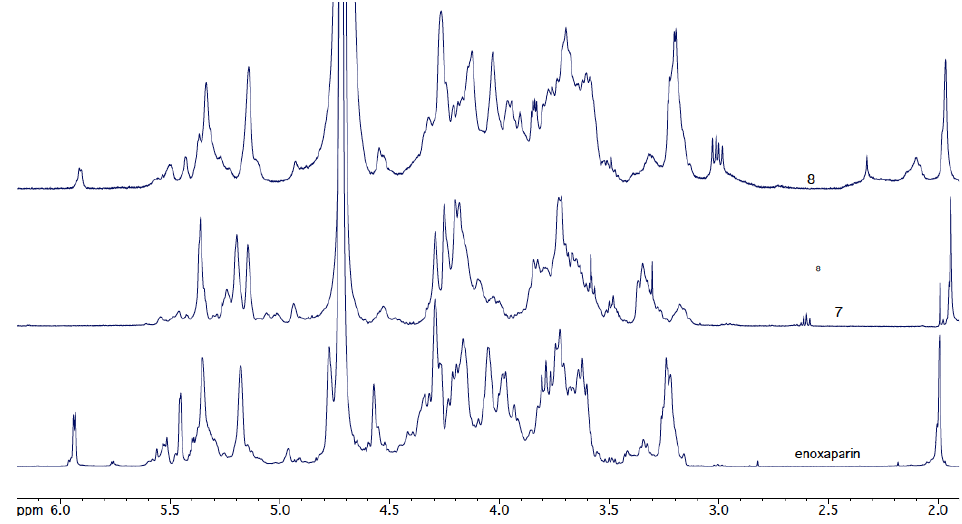
Figure 9. Stacked NMR spectra from 1.9 to 6.2 ppm on enoxaparin, 7 and 8. (Intensities scaled so that NAc peaks near 2.0 are all of equal intensity).